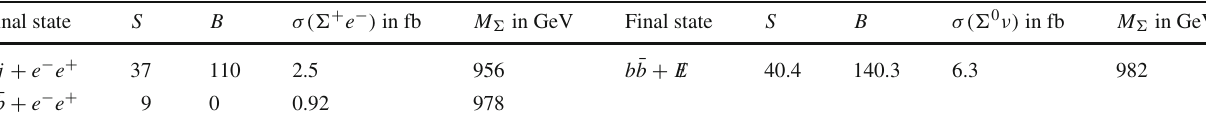
Table 9 The mass reach at 1 TeV with integrated luminosity of 100 fb − 1 from selected channels of single production of charged and neu- tralfermions,giving3 σ sensitivity.Thecorrespondingproductioncross